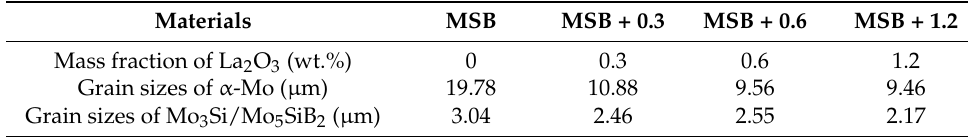
Table 1. The La 2 O 3 mass fractions and grain sizes of various samples studied. Reproduced with permission [80]. Copyright 2011 Elsevier.